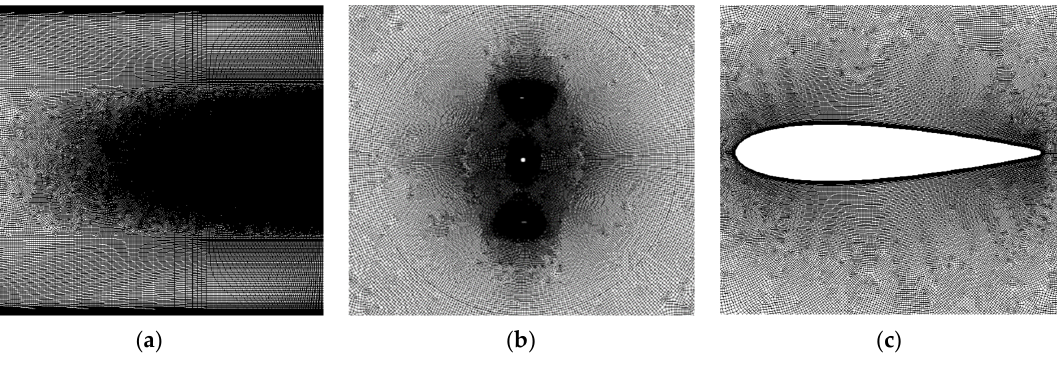
Figure 3. Details of computational grid used in the present work. ( a ) Overall grid of the entire domain; ( b ) Mesh in the rotation part of domain ( c ) grid around the wind turbine blade.